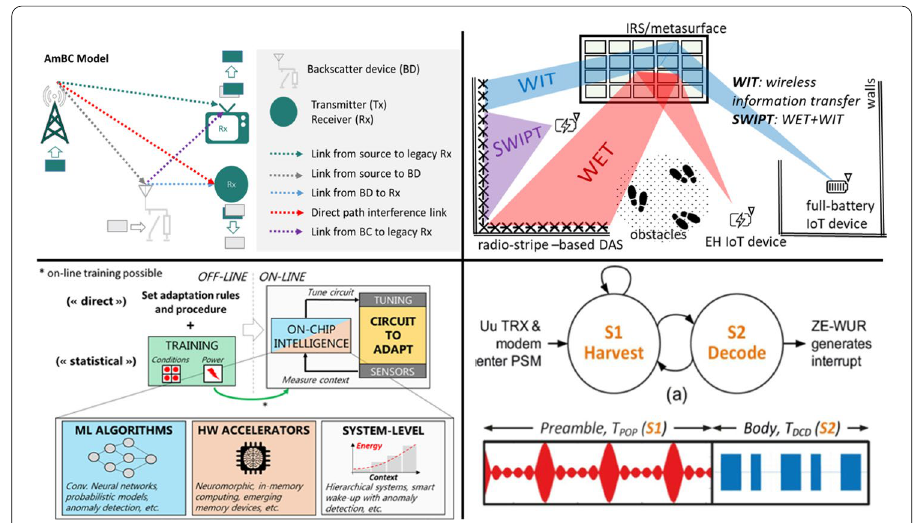
Fig. 3 Zero‑energy MTC enablers. AmBC system model (top, left); Radio stripe and IRS‑enabled efficient WET (top, right); Illustration on possible strategies for on‑chip device intelligence (bottom, left); and Illustration of the ZE air interface operation (bottom,